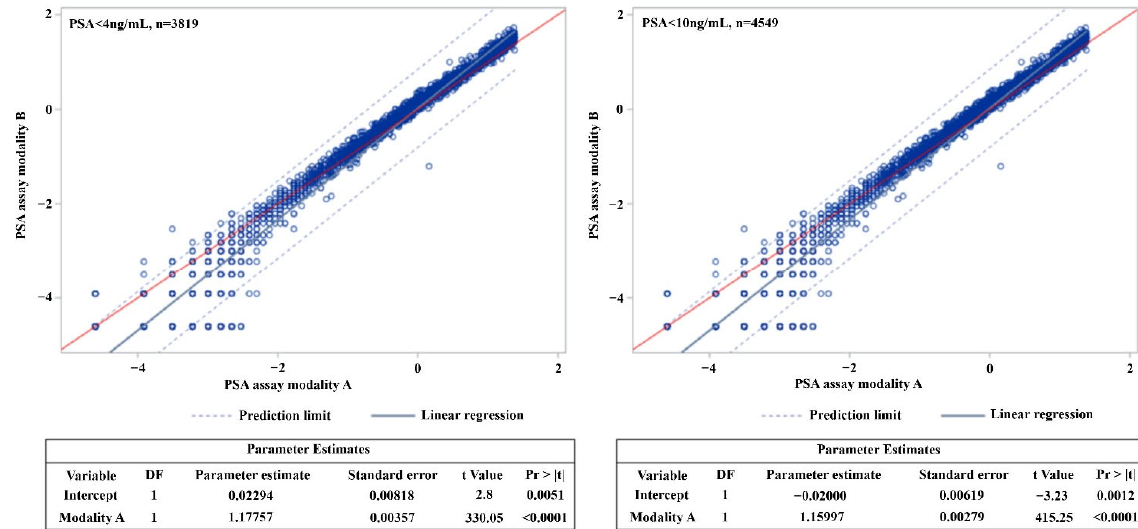
Figure 1. Logistic regression according to two prostate-specific antigen (PSA) assay modalities. The point where the regression line meets the straight line with a slope of 1 in PSA < 4 ng/mL group: 0.878808304. The point where the regression line meets the straight line with a slope of 1 in PSA < 10 ng/mL group: 1.133175017. DF: degrees of freedom, Pr: probability.